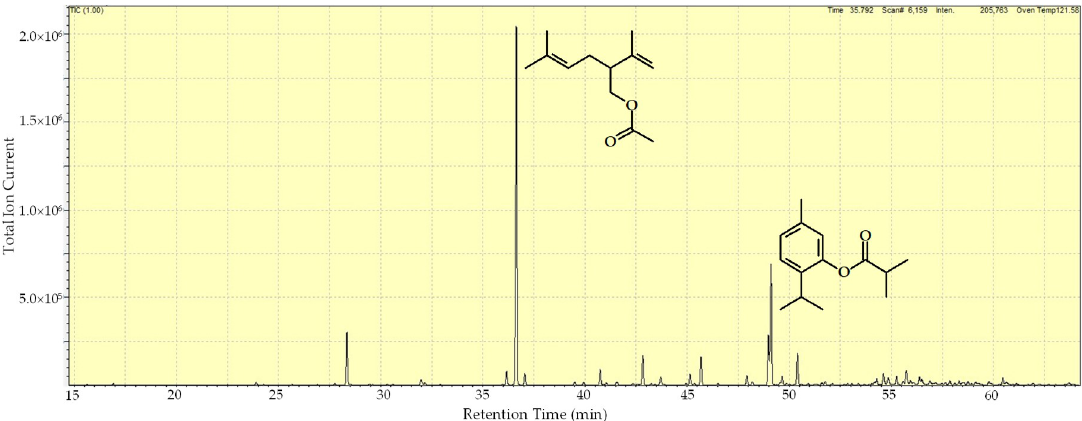
Figure 2. Gas chromatogram and major components of the essential oil extracted by hydrodistillation from P. matricarioides collected in Bauta municipality, Artemisa, Cuba.